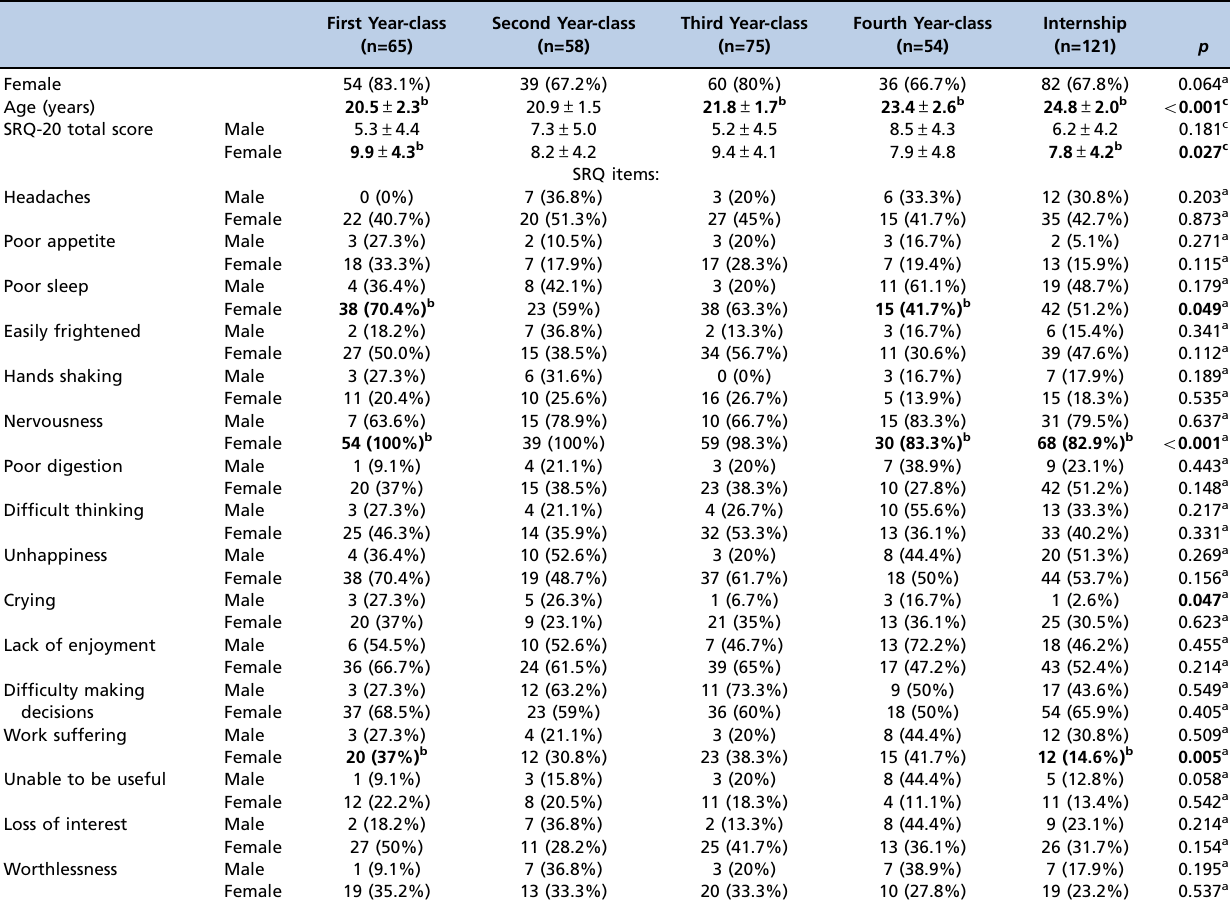
Table 2 - Analysis of self-reporting questionnaire with 20 items (SRQ-20) and Interpersonal Reactivity Index (IRI) of each year-class